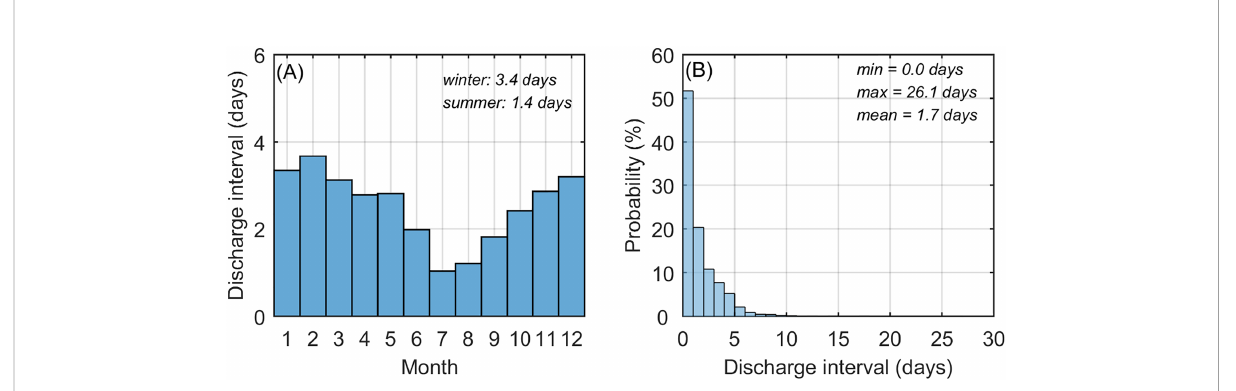
FIGURE 1 Interval between freshwater discharges from Geum River estuarine dam during 1994-2016. (A) Long term average discharge interval by month, (B) discharge interval probability distribution. Winter is December – February and summer is July – September. Data provided by the Korea Rural Community